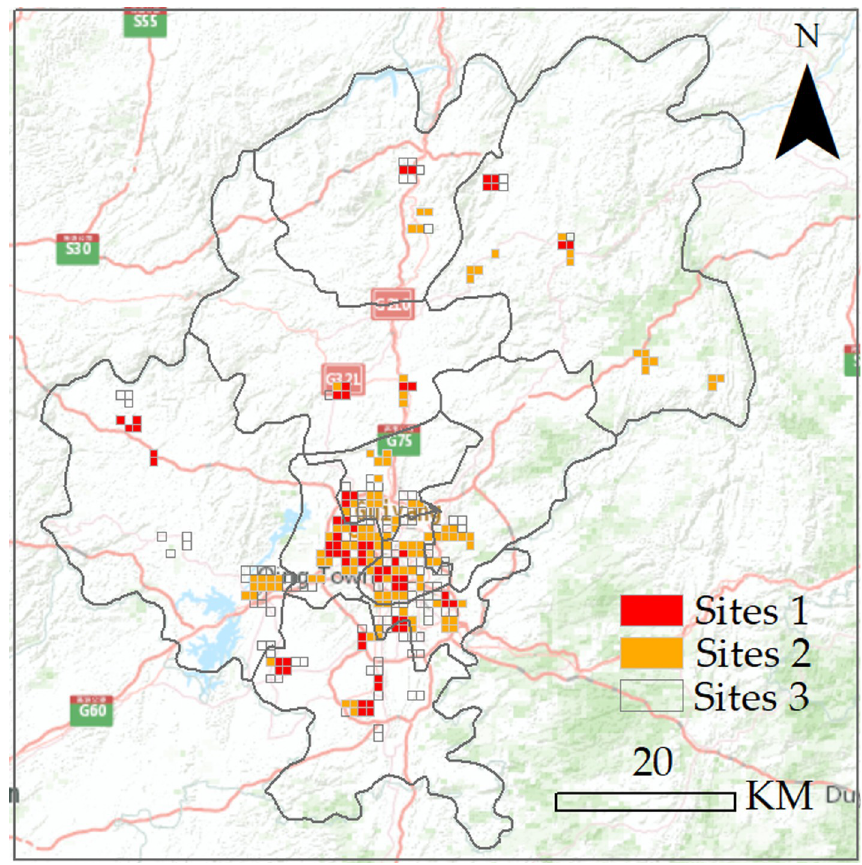
Fig 6. Changing tendency of consumption potential of each distinct between 2014 and